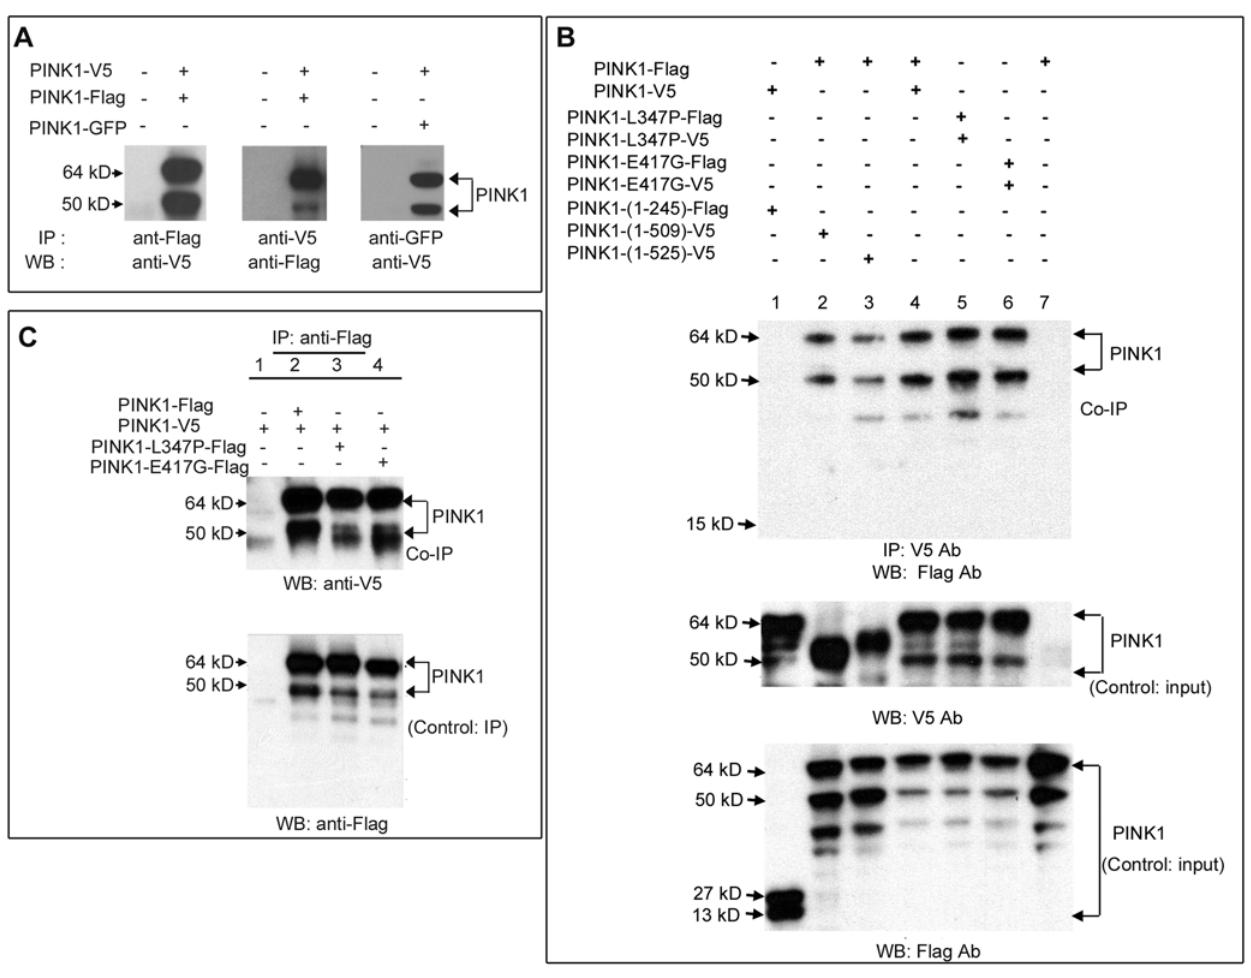
Figure 3. Dimerization of PINK1 via the kinase domain. In all experiments, PINK1 with different tags were co-transfected in pairs into HEK293 cells. A tag was used for immunoprecipitation (IP), and Ab against another tag was used for Western blots (WB). Results were confirmed in COS and HeLa cells (data not shown). A) Wild type PINK1 form dimers. Left lanes in all three panels: lysate from cells without transfection as negative controls; right lanes in all panels: lysate from cells co-transfected with a pair of PINK1 constructs. In the left and middle panels, PINK1-Flag and PINK1-V5 were co-transfected. Anti-Flag Ab could co-IP PINK1-V5 (left panel) and vice versa (middle panel), indicating that PINK1-Flag and PINK1-V5 form a dimer. PINK1 dimerization is confirmed when PINK1-GFP and PINK1-V5 were co-transfected, anti-GFP Ab could co-IP PINK1-V5 (right panel). B) Wild type and mutant PINK1 form homo-dimers via the kinase domain. Lysates from cells expressing PINK1-V5 and PINK1 1-245 -Flag (lane 1), PINK1-Flag and PINK1 1- 509 -V5 (lane 2), or PINK1-Flag and PINK1 1-525 -V5 were isolated (lane 3), and subject to Western analysis with V5 antibody (middle panel, input control) or Flag antibody (bottom panel, input control) to confirm the expression of expected tagged recombinant protein. These lysates were then immunoprecipitated with mouse anti-V5 Ab, and subjected to Western analyses with rabbit anti-Flag Ab (upper panel; Co-IP). PINK1 1-245 -Flag abolished dimerization (lane 1), whereas PINK1 1-525 -V5 and PINK1 1-509 -V5 could dimerize normally (lanes 2 and 3). Thus amino acid residues 246–509 are necessary for dimerization. L347P and E417G mutations did not disrupt the PINK1-PINK1 interaction (lane 5 and 6). C) Mutant PINK1 can also form hetero-dimers with wild type PINK. Lysates from cells expressing 1) PINK1-V5, 2) PINK1-V5 and PINK1-Flag, 3) PINK1-V5 and PINK1-L347P-Flag, 4) PINK1-V5 and PINK1-E417G-Flag were isolated and immunoprecipitated with rabbit anti-Flag Ab. The IP and Co-IP fractions were then subjected to Western analyses with mouse anti-V5 Ab (upper panel, Co-IP) or mouse anti-Flag Ab (lower panel, control IP). Wild type PINK1 form dimers (lane 2), and the disease-causing PINK1 mutations did not affect the dimerization (lanes 3, 4).